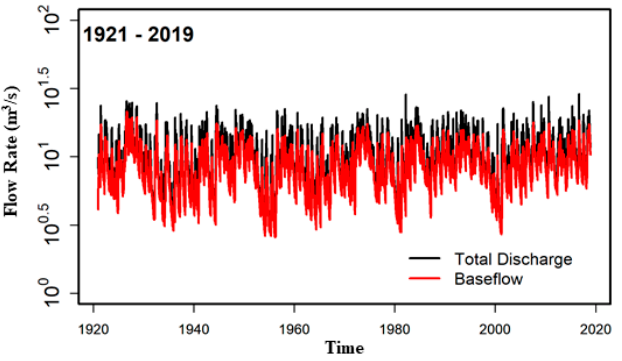
Figure 5. Separation of flow components for Greer Spring using WHAT.